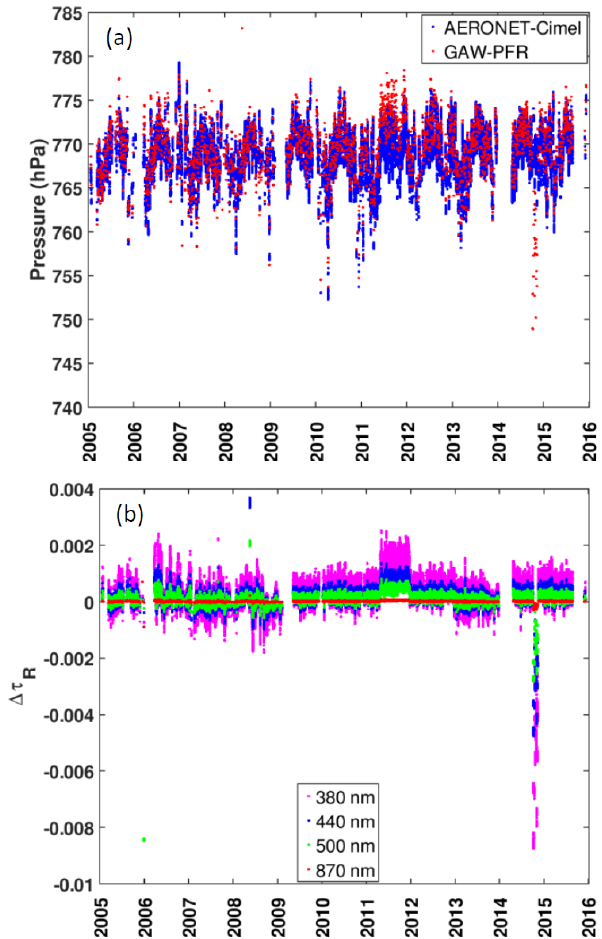
Figure 4. (a) The 1min pressure data (hPa) from GAW-PFR and 6h pressure data at Izaña Observatory from the National Centers for Environmental Prediction (NCEP) and the National Center for At- mospheric Research (NCAR) reanalysis for the case of AERONET- Cimel and (b) corresponding 1min (cid:49)τ R caused by pressure differ- ences in the period